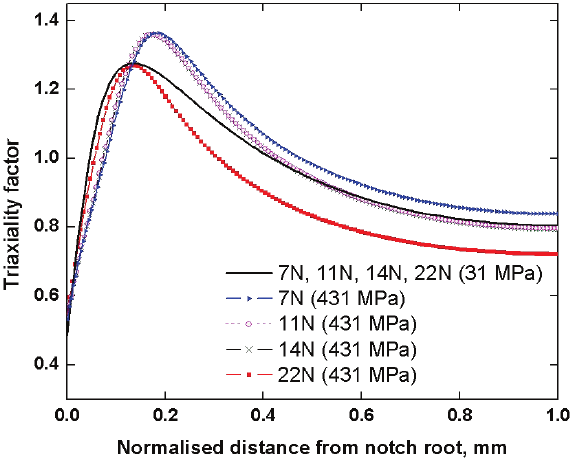
Figure 11. Influence of nitrogen on triaxiality factor for 316LN at nominal stresses of 31 and 431